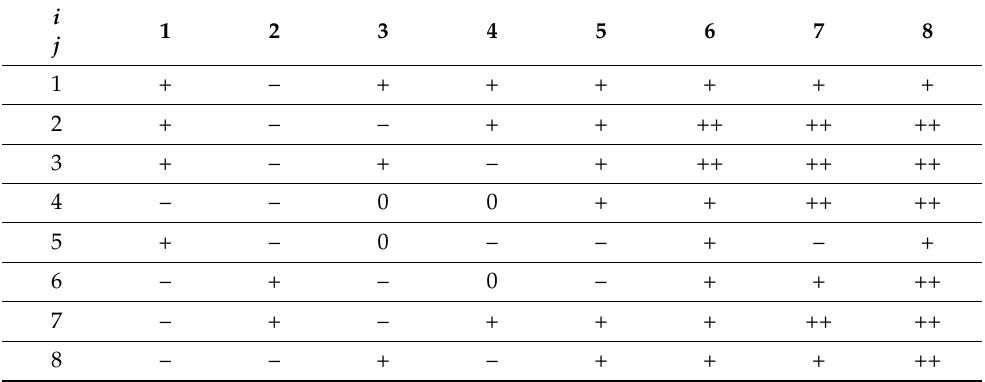
Table 5. Results of hydrolysis influence on the instability of porosity.